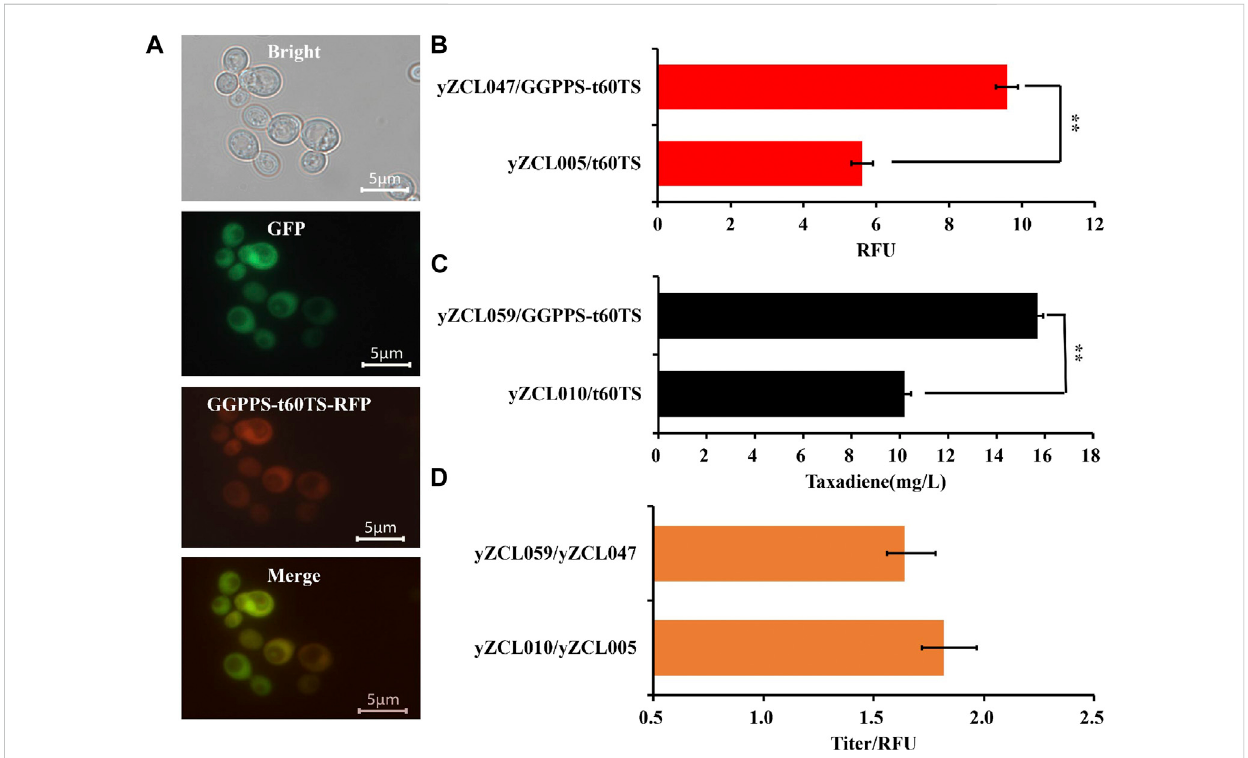
FIGURE 4 EffectoffusionproteinGGPPS-t60TSonsubcellularlocalization andperformanceofTSin S.cerevisiae . (A) Subcellularlocalizationoffusionprotein GGPPS-t60TSin S.cerevisiae . (B) Effect of fusion proteinGGPPS-t60TS onthe expression ofTS. (C) Effect offusion protein GGPPS-t60TSon theyield of taxadiene. (D) Effect of fusion protein GGPPS-t60TS on unit enzyme activity of TS. The error bars represent the means ± SD from three biological replicates. **p < 0.01, *p < 0.05, student ’ s t